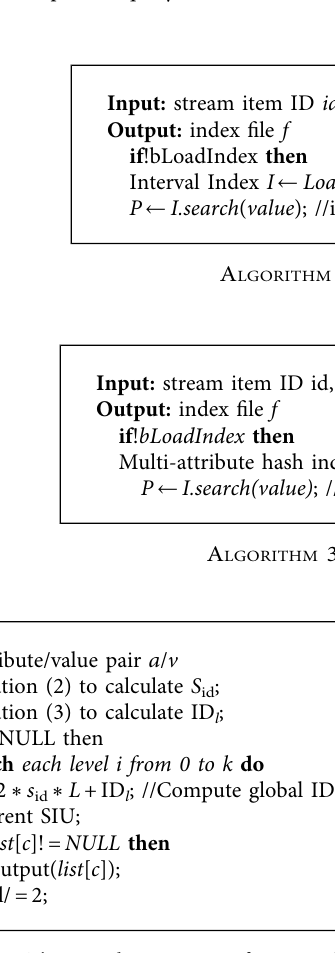
Figure 8: The merging procedure in Reducer. For coming event, if it is a new stream item, we invoke the multiattribute index scanning procedure to add the item ID to the event list. Otherwise, if the coming event is an intermediate result from Mapper, we inspect the event list; if we find the ID, we inspect all query clusters to find satisfied queries and output the query